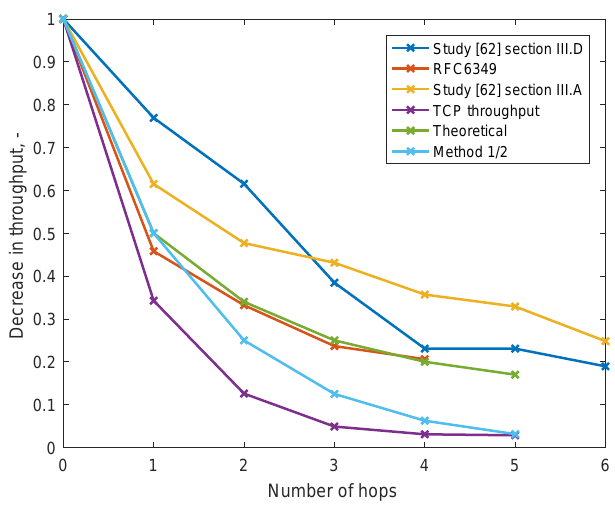
Figure 11. Decrease in throughput caused by linear topology of repeaters for different